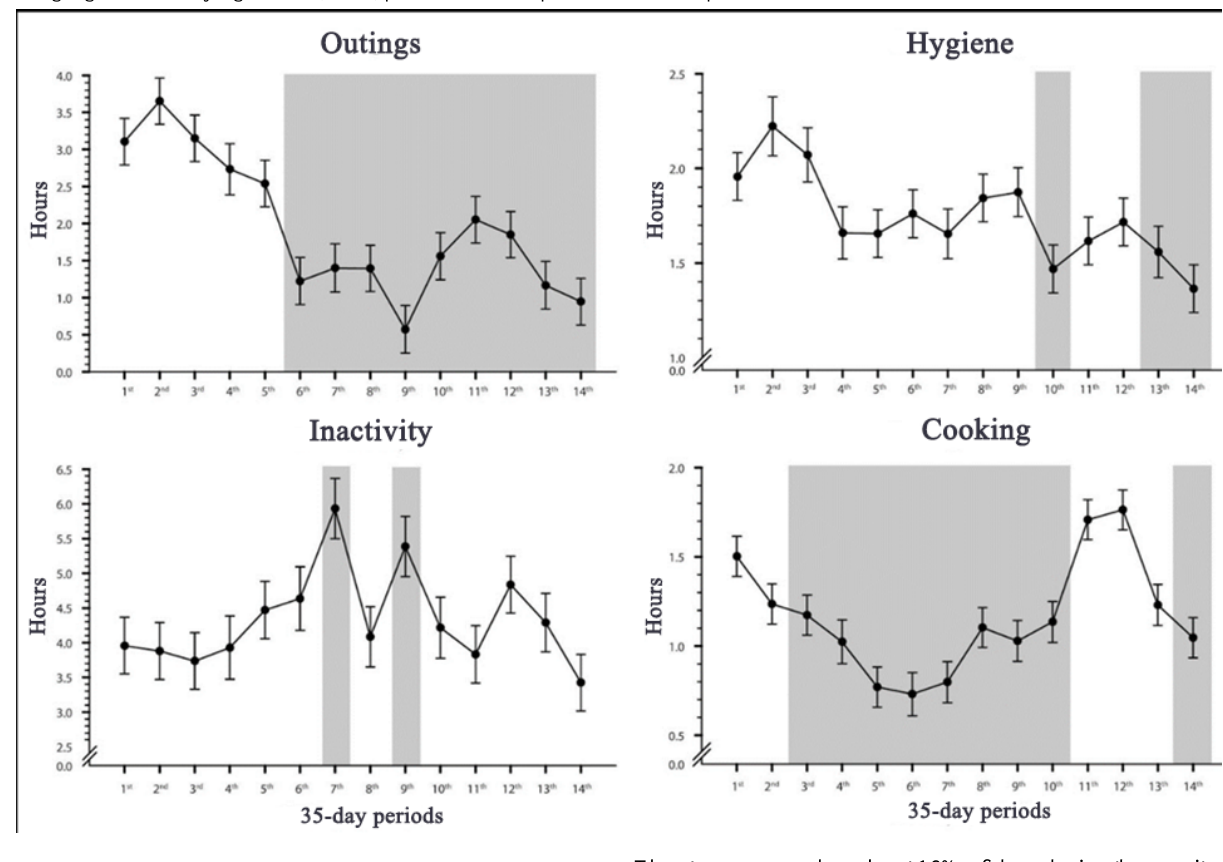
Figure 3. Evolution of estimated means (SE) for outings, bathroom usage, low mobility, and cooking activities during the monitoring period. The gray zones highlight statistically significant ( P <.05) periods when compared with the first